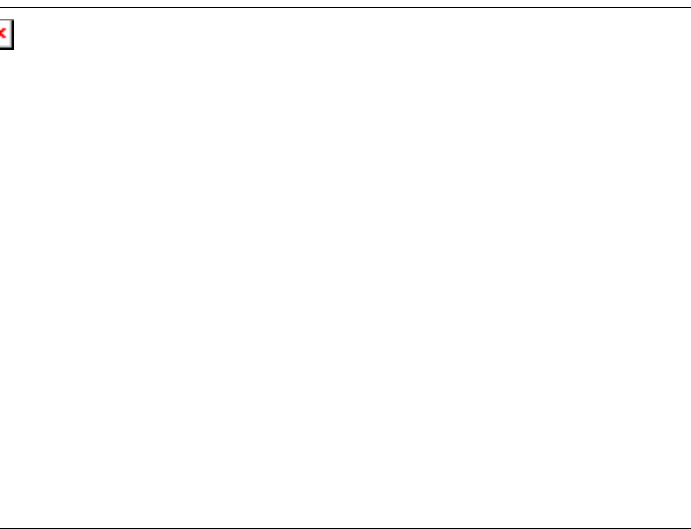
Figure 1 Hierarchical analysis of